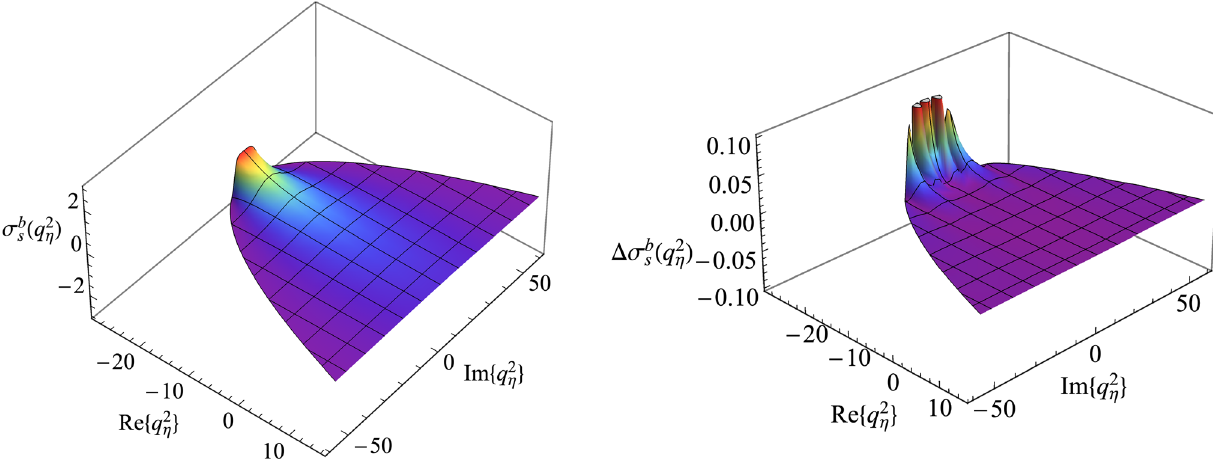
= 9 . 392 GeV) , η = 1 / 2, m η b b